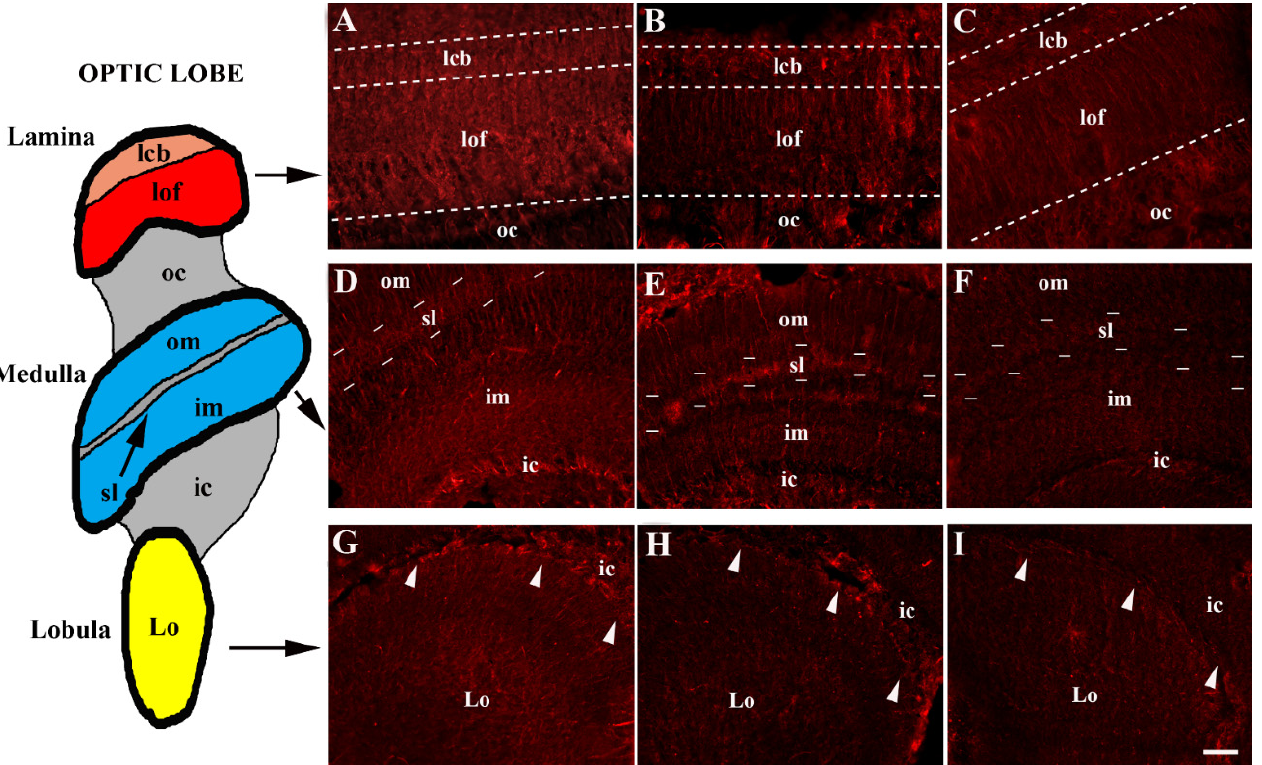
Figure 2. Distribution of serotonin transporter (SERT)-immunoreactive fibres in lamina ( A – C ), medulla ( D – F ) and lobula ( G – I ) of docile ( A , D , G ), moderate ( B , E , H ) and aggressive ( C , F , I ) honeybees. In the lamina, SERT-immunoreactive fibres were located in the cell body layer (lcb). The lamina showed many SERT-immunoreactive fibres in the layer of fibres (lof). The outer medulla (om), the serpentine layer (sl) and the inner medulla (im) contained many SERT-immunoreactive fibres distributed across the different strata of the lobula. Immunoreactive fibres were also located in the outer chiasma (oc) and inner chiasma (ic). Note that, in the lamina, medulla and lobula, the immunoreactivity for the SERT decreased from docile to aggressive honeybees. Arrowheads indicate the border between lobula and inner chiasma. Scale bar: 10 μ m.